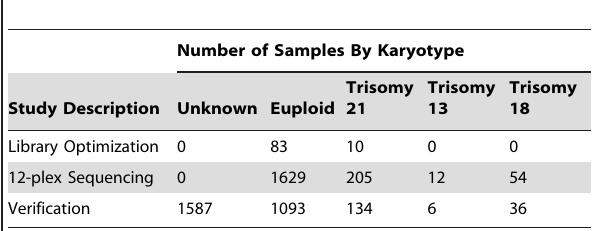
Table 1. Summary of sample types utilized for each of the studies